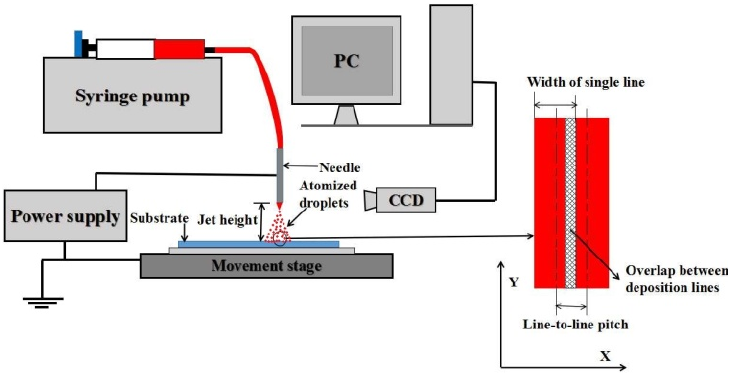
Figure 2. Schematic of the E ‐ jet deposition apparatus.